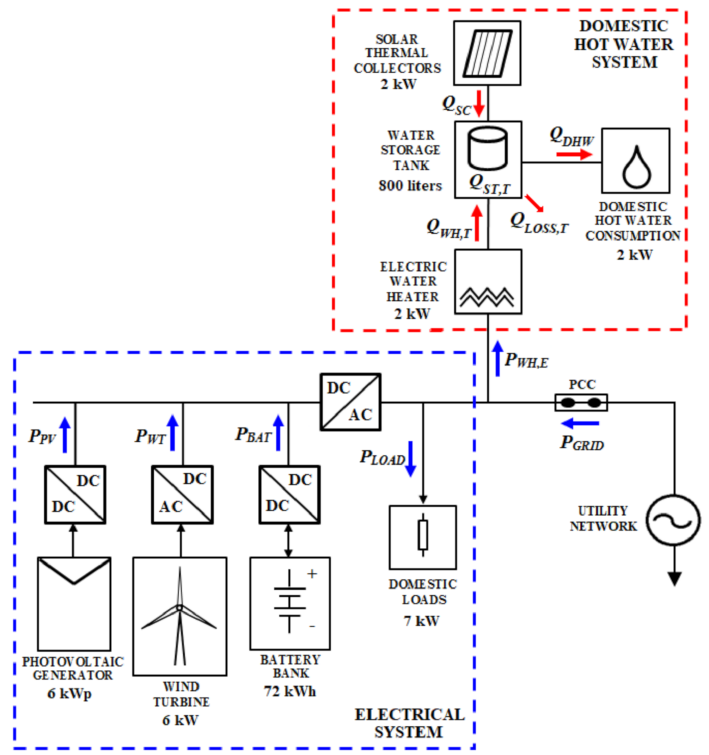
Figure 1. Electro-thermal microgrid